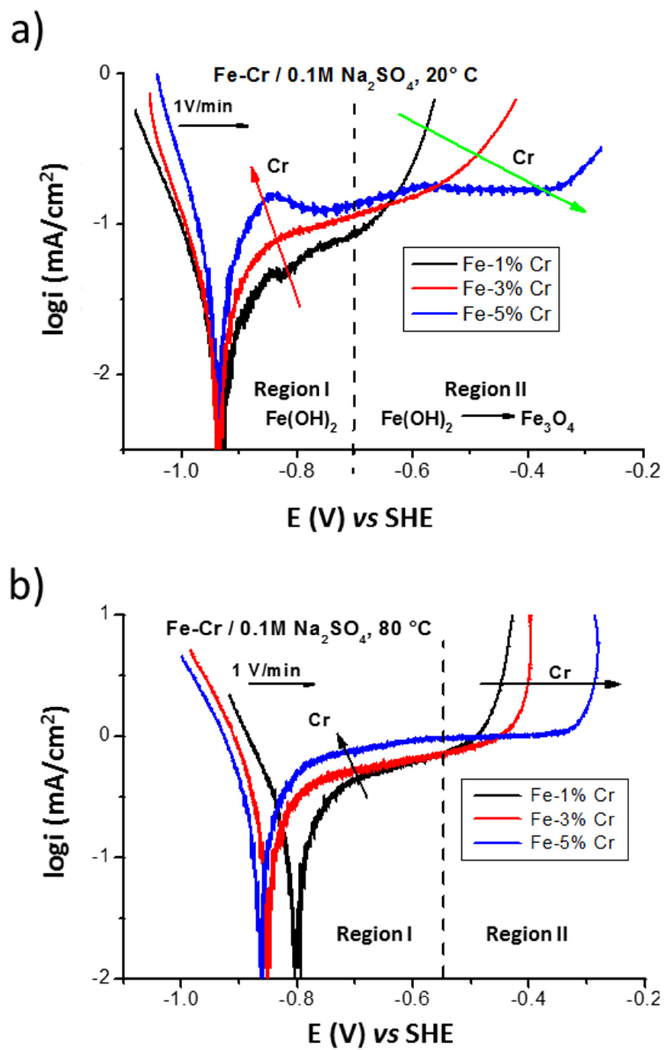
Figure 3. The influence of the chromium content on the polarization of the Fe-Cr ferritic alloys in 0.1 M Na 2 SO 4 performed with scan rate v = 1 V/min at 20 °C ( a ) and 80 °C ( b ).